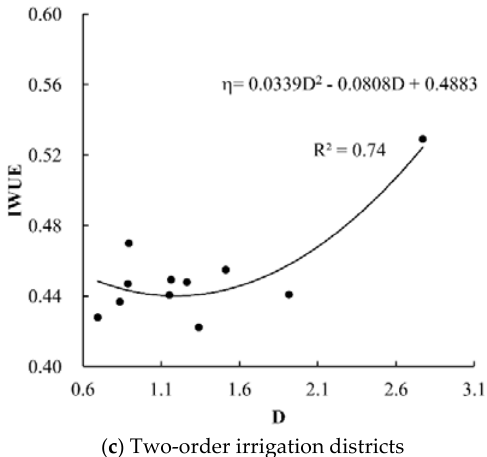
Figure 4. Scatter chart of the IWUE and D values for canal systems at all levels and classified sampled irrigation districts.